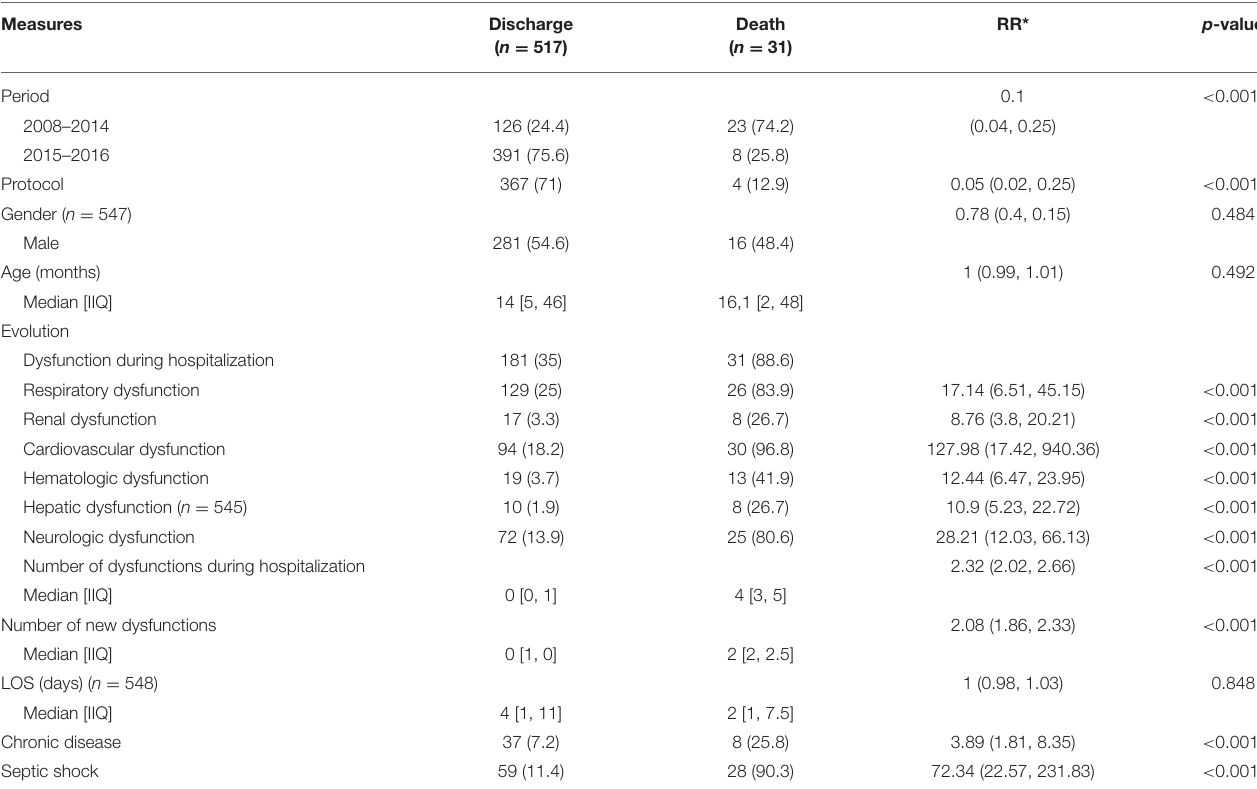
TABLE 2 | Factors associated with